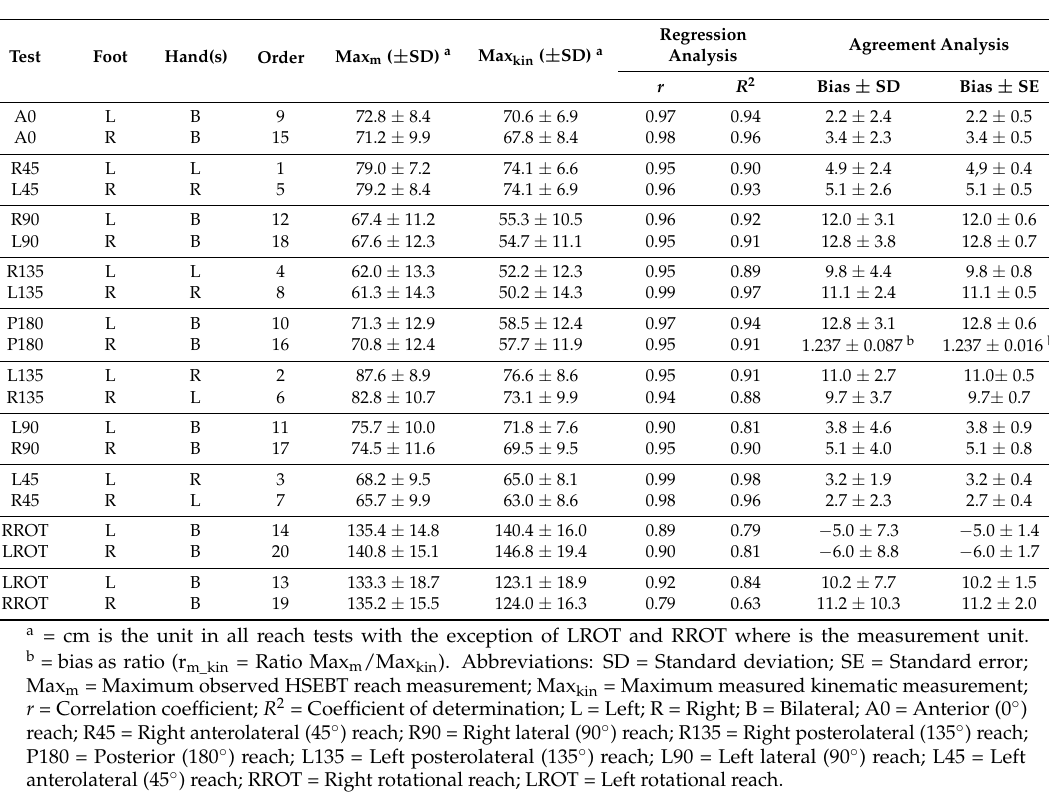
Table 3. Validity of HSEBT.